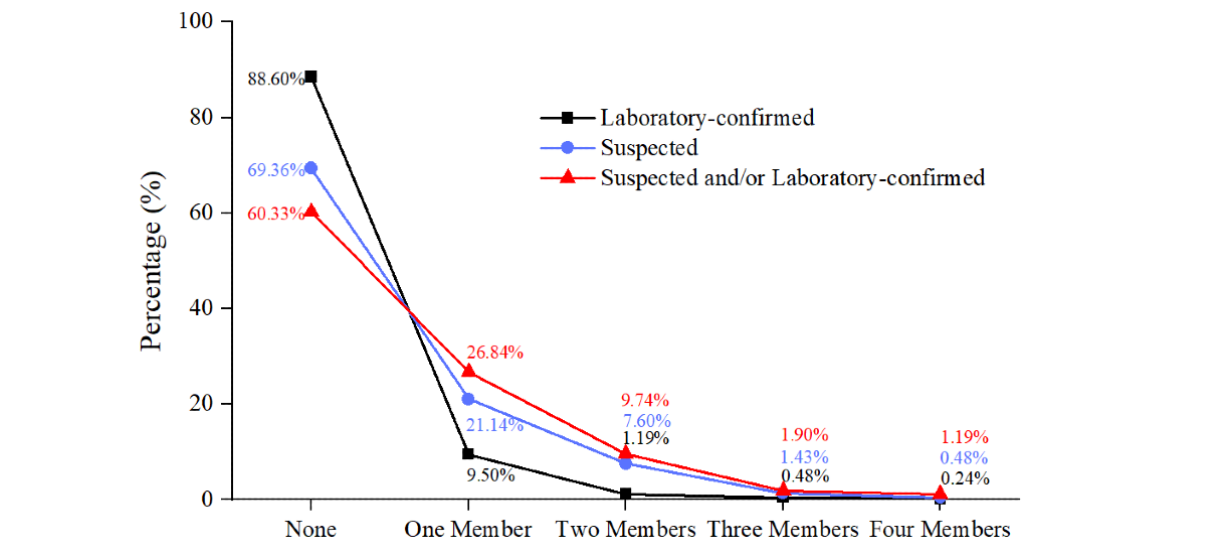
Figure 3. The distribution of family clusters.